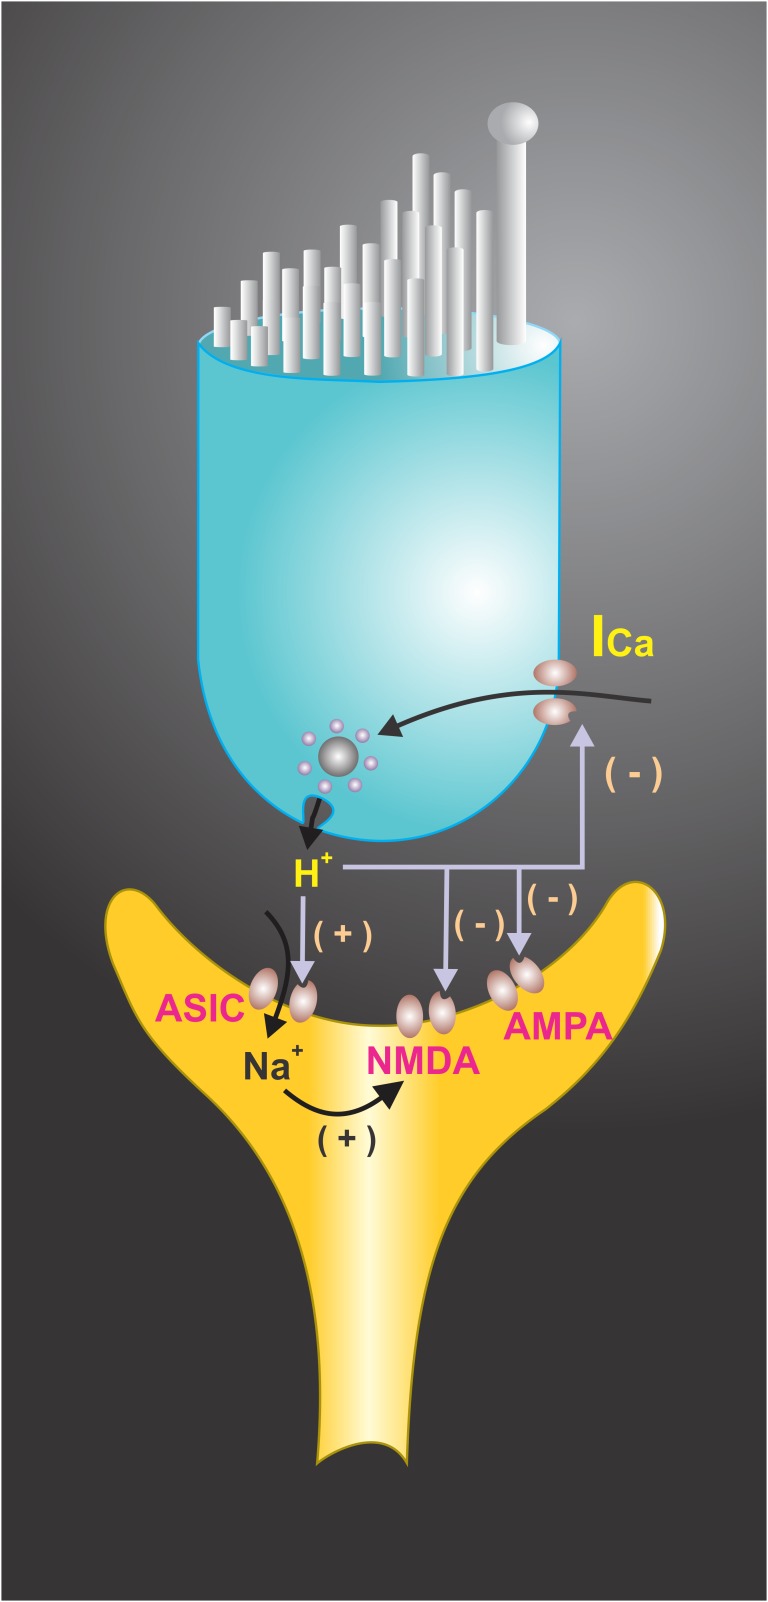
Extracellular protons have been shown to modulate voltage-activated ionic channels in hair cell receptoneural junctions. Presynaptic K+ and Ca2+ currents are modulated by H+, suggesting that they may function as a synaptic feedback mechanism in hair cells. A shift in the voltage dependence of the Ca2+ current to a more positive membrane potential was achieved at pH < 6.8. Extracellular pH also modulates the NMDA and AMPA receptors response to afferent transmitters and interacts with ASICs located at the synaptic endings, contributing to EPSC. The end result of H+ interactions with ionic channels may boost the postsynaptic response and restrict the release of neurotransmitters.